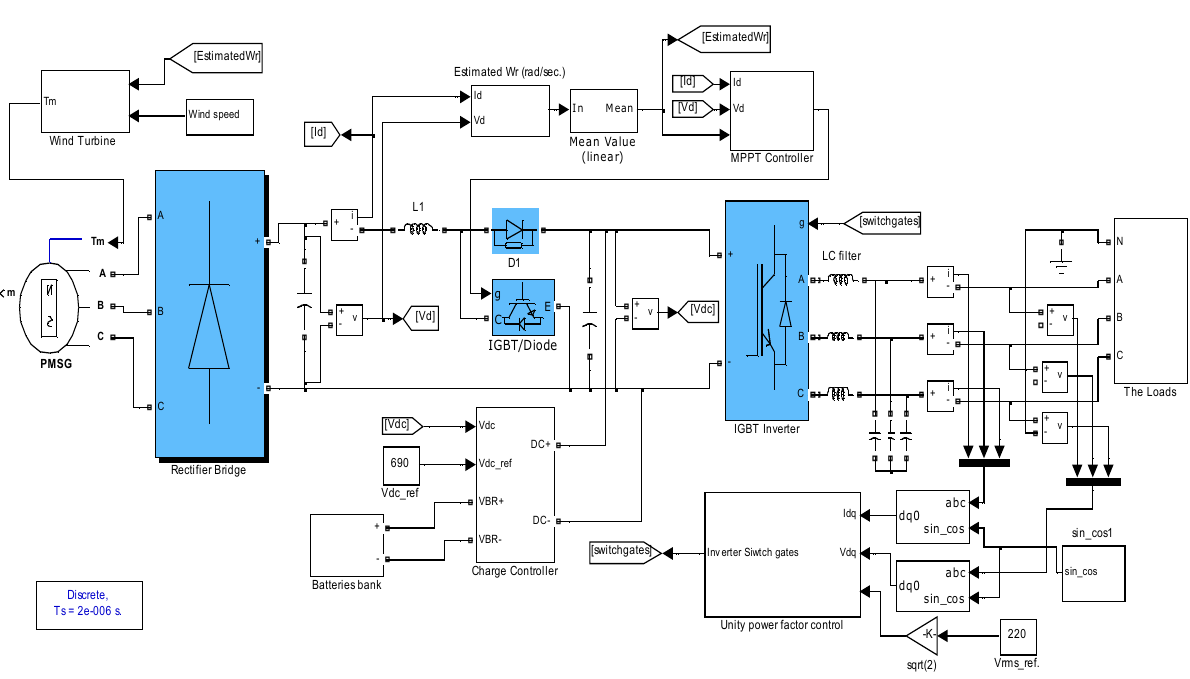
Figure 10. Simulation block diagram .